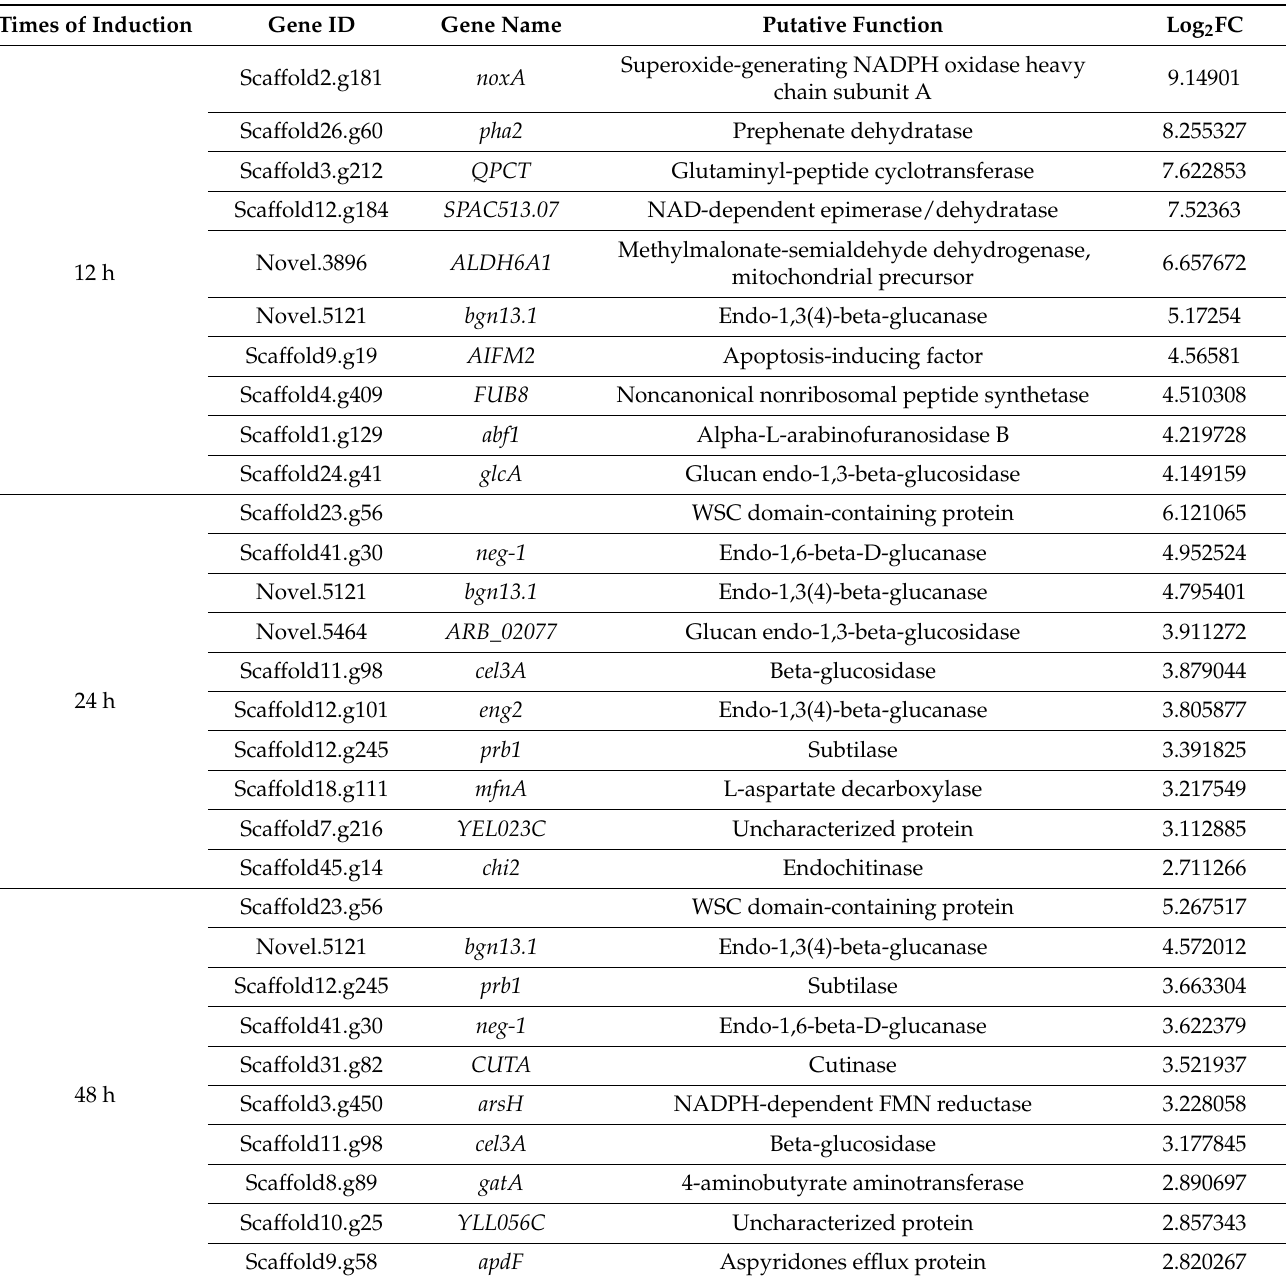
Table 3. Log 2 fold change of the top 10 DEGs in T. harzianum T4 treated with BCCW at 12, 24, 48 and 72